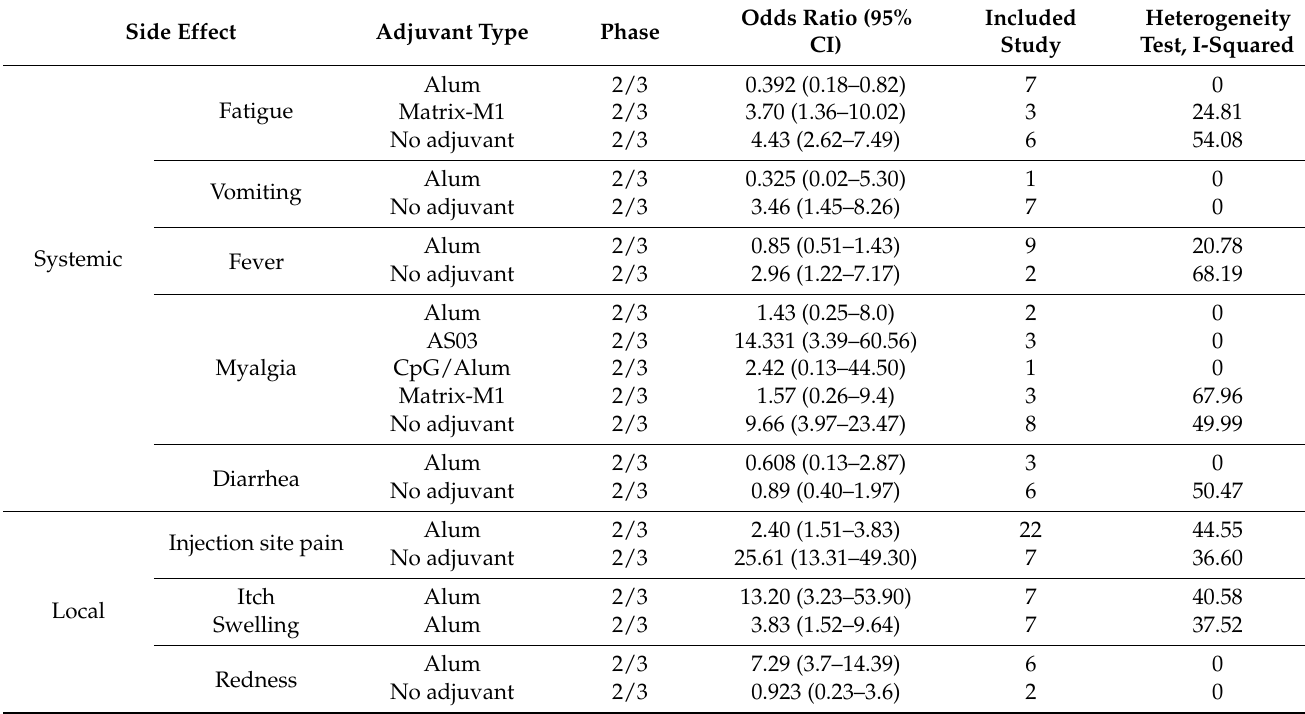
Table 5. Side effects of COVID-19 vaccines based on different adjuvant types. Side